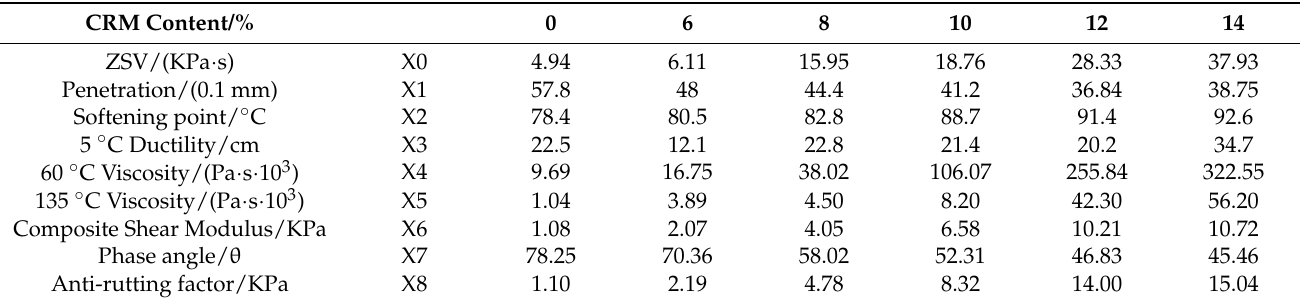
Table 6. Gray correlation analysis of ZSV and the other properties for the hybrid modified asphalt binders with Shuang long base binder.